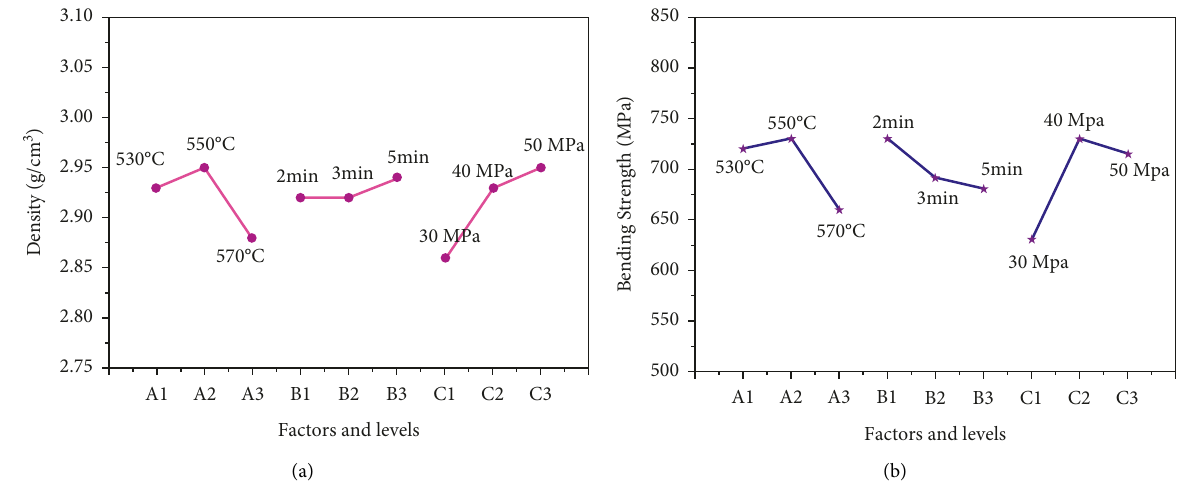
Figure 2: Impact factors of (a) density and (b) ending